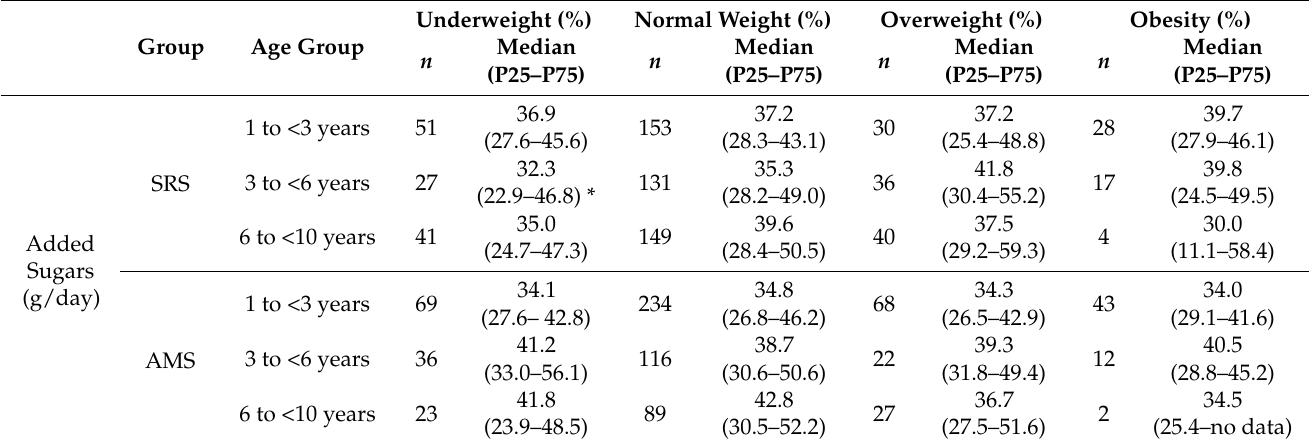
Table 5. Added sugars usual intakes by age group and body composition in the Spanish Pediatric Population (EsNuPI)